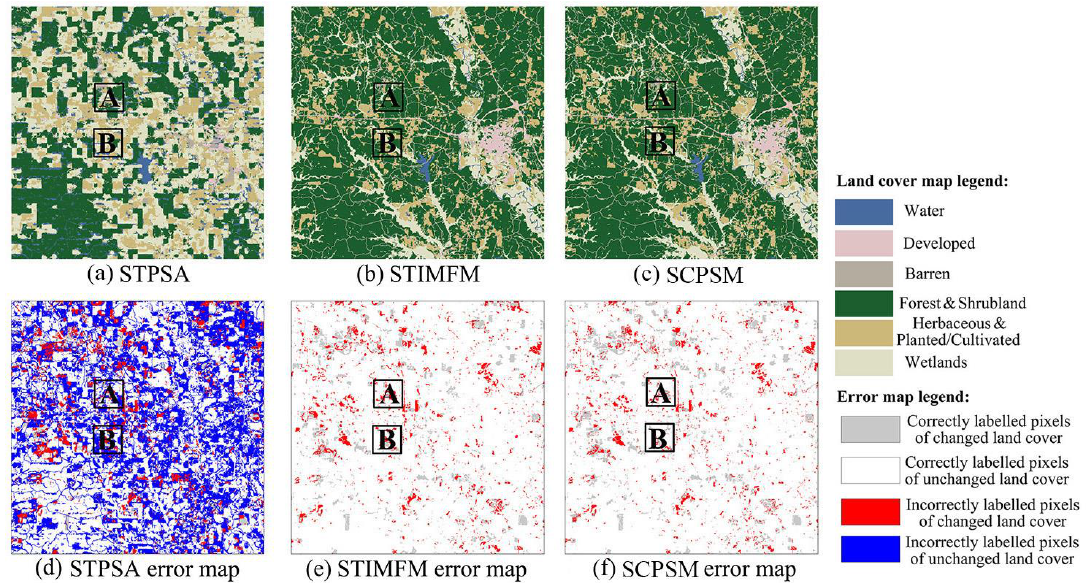
Figure 6. The result of land cover maps predicted from di ff erent methods, and the corresponding error maps in the NLCD experiment. ( a ) spatio-temporal PSA-based SPM (STPSA); ( b ) spatio-temporal image and map fusion model (STIMFM); ( c ) same-class pixels-based STSPM model (SCPSM); ( d ) STPSA error map; ( e ) STIMFM error map; ( f ) SCPSM error map.